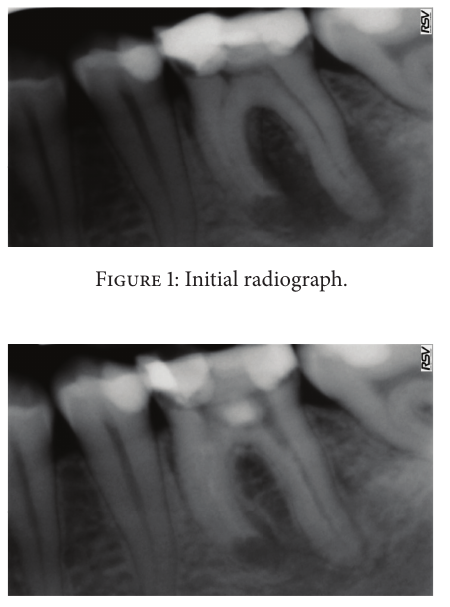
Figure 2: Radiograph with temporary therapeutic agent.